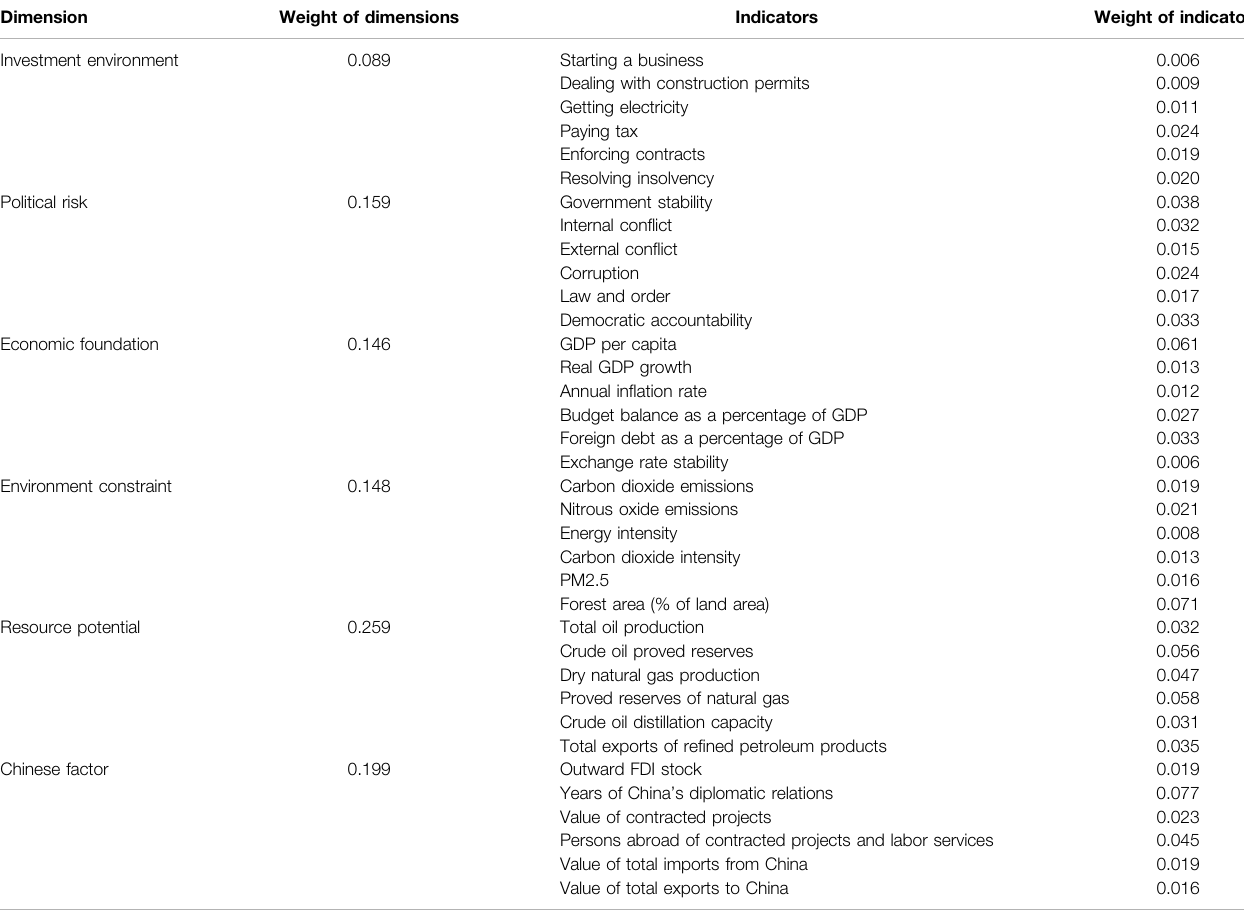
TABLE 3 | Estimated weights of risk evaluation indicators for six